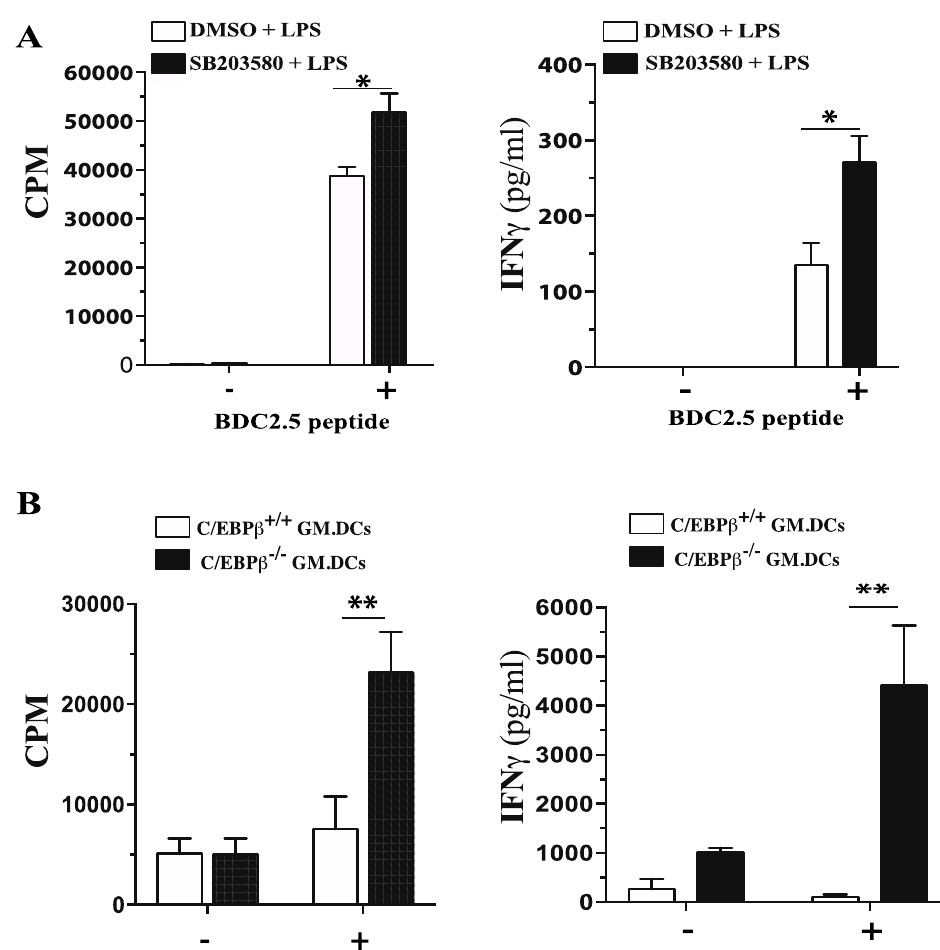
Figure 7. Elevated CD4 + T cell proliferation and IFNγ production induced by the p38 MAPK inhibitor-treated or C/EBPβ-deficient GM/DCs. ( A ) Proliferative response and IFNγ secretion by autoreactive BDC2.5-CD4 + T cells that had been cultured with GM/DCs treated with p38 MAPK inhibitor SB203580 or with vehicle (DMSO) and pulsed or not with BDC2.5-peptide. ( B ) Proliferative response and IFNγ secretion by naïve CD4 + T cells purified from C/EBPβ +/+ littermate control mice that have been activated with anti-CD3 and anti-CD28 Abs in the presence of C/EBPβ +/+ or C/EBPβ −/− GM/DCs before (−) and after (+) LPS stimulation. Quantification of IFNγ released in the supernatant. Data are representative of three independent experiments and are shown as the mean ± SD. The asterisks (*) correspond to p < 0.01 (**), one-way ANOVA with post hoc Bonferroni’s test.